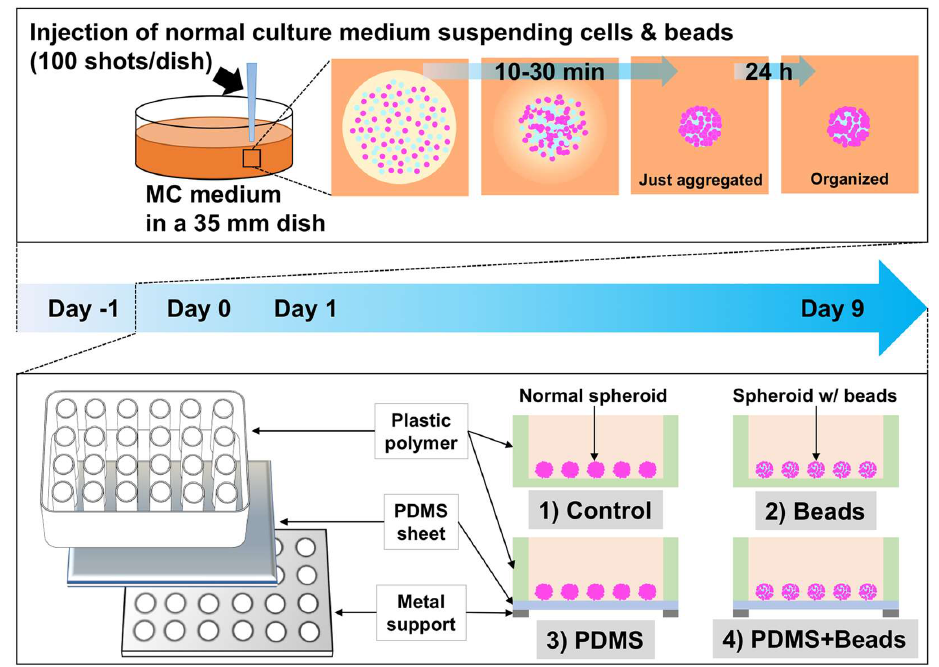
Figure 1. Schematic illustration of hydrogel bead-embedded spheroids and gas-permeable plate. Cells/beads suspended in normal culture medium were injected into 3% MC medium. The injected normal culture medium was adsorbed by the surrounding MC medium and the cells/beads aggregated between 10 and 30 min after injection. The aggregated cells/beads were cultured for 24 h without settling because of the high viscosity of the 3% MC medium, and 24 h was sufficient to organize the spheroids containing hydrogel beads. After 24 h, the spheroids were isolated from the MC medium using cellulase to reduce its viscosity. The conventional and bead-containing spheroids were then cultured on either normal polystyrene plates or ones with gas-permeable PDMS bottoms. Hydrogel beads and PDMS were expected to enhance oxygen supply to the spheroids.